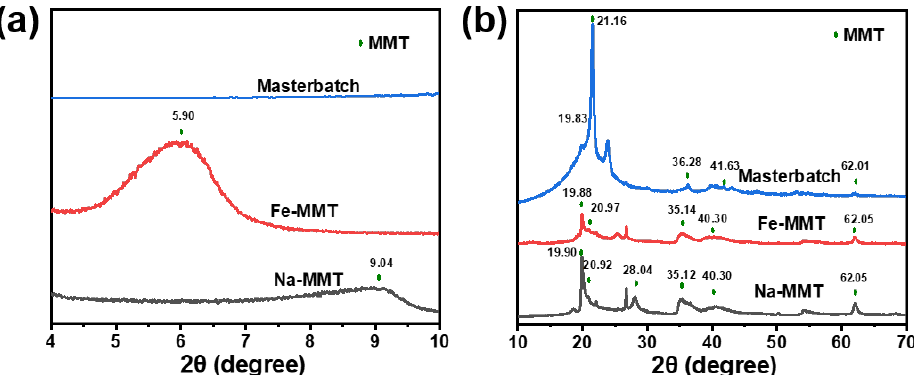
Figure 1. Small-angle XRD patterns ( a ) and wide-angle XRD patterns ( b ) of Na-MMT, Fe-MMT, and masterbatch.